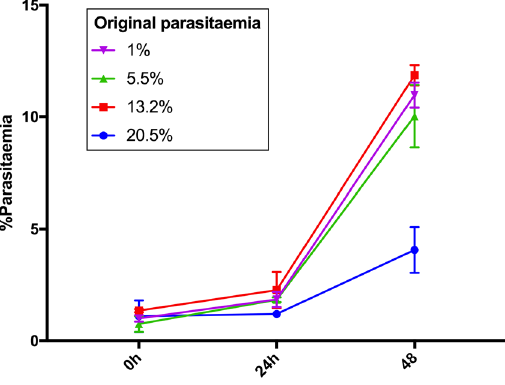
Figure 1. Highest parasitaemia growth. Cultures coming from 1%, 5.5%, 13.2% and 20.5% parasitaemias were split to 1% and monitored for 48